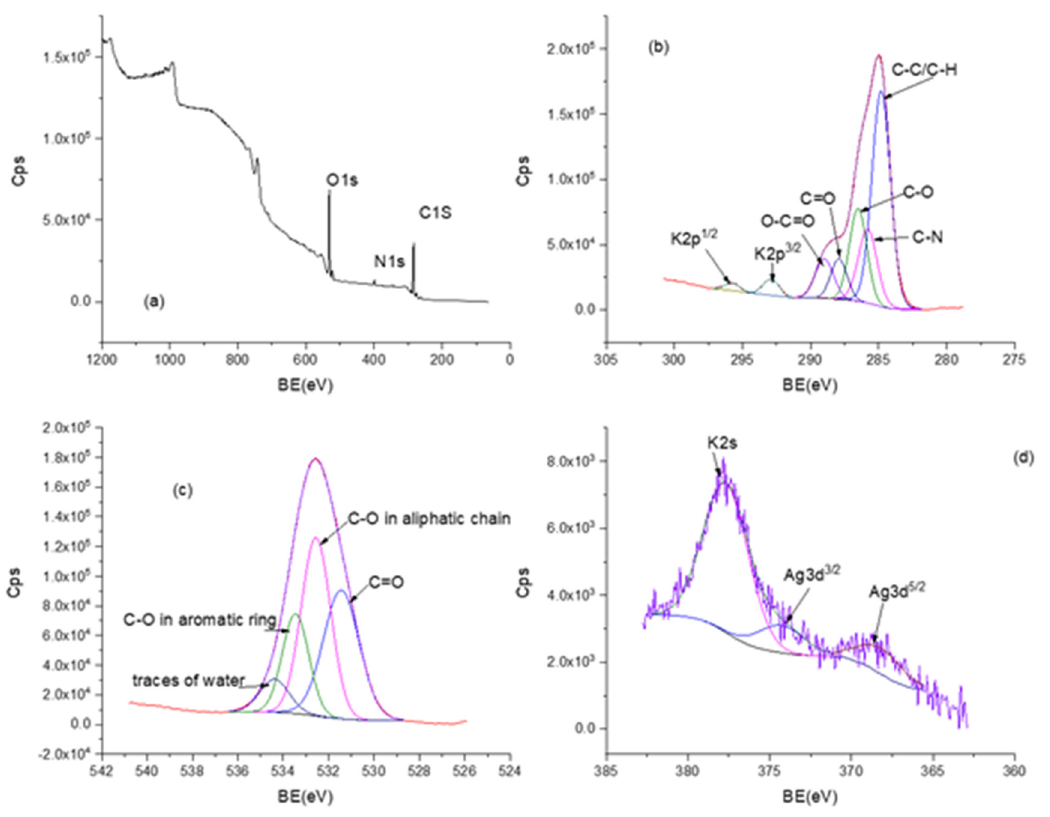
Figure 5. X-ray Photoelectron Spectroscopy (XPS) spectra of MNT-nAg-PCT sample: survey spectrum ( a ); C1 spectrum ( b ); O1 spectrum ( c ); Ag3d spectrum ( d ).